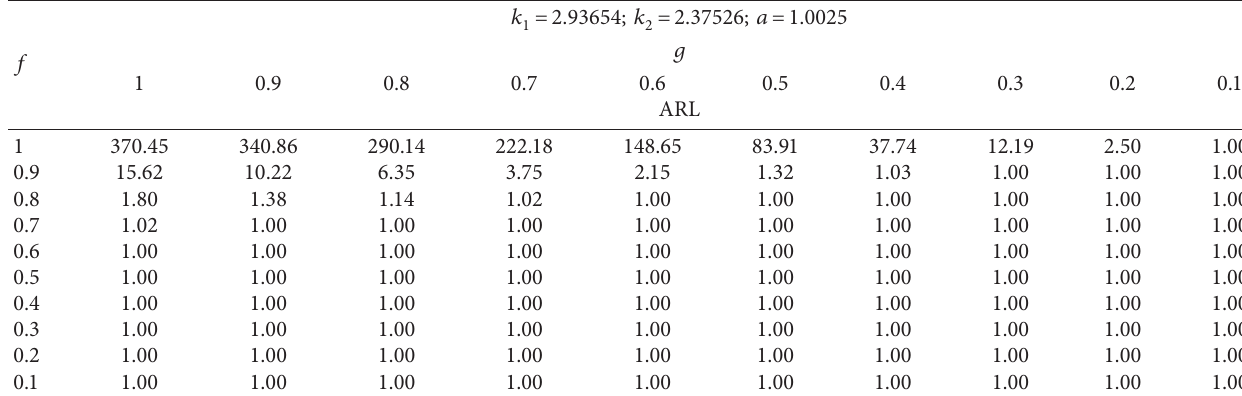
Table 2: The values of ARLs when b � 0.31, n � 30, and i �